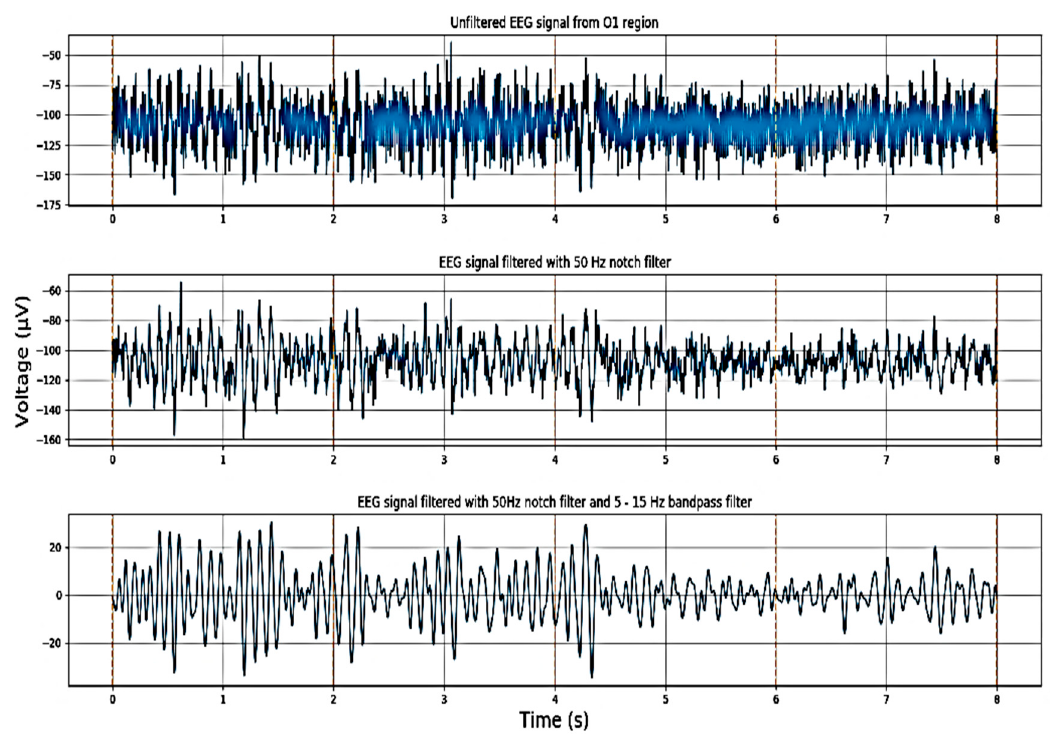
Figure 5. From top to bottom: Unfiltered electroencephalography (EEG) signal, EEG signal after being filtered with a 50 Hz notch filter, and final EEG signal with additional 5–15 Hz bandpass filter application.